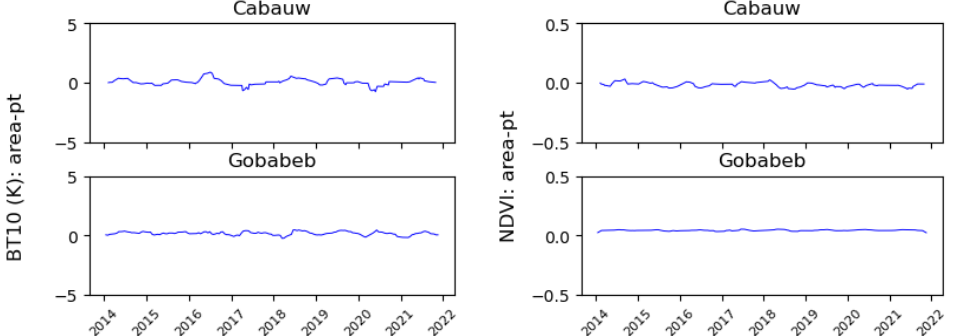
Figure 15. The heterogeneity analysis of BSRN stations over BT10 ( left ) and NDVI variable ( right